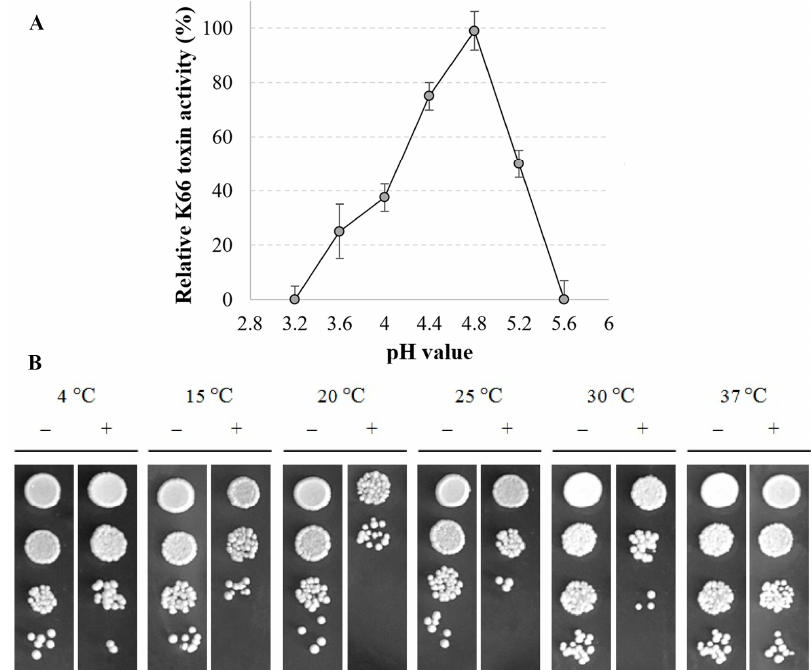
Figure 4. Impact of pH and temperature on K66 toxin functionality. ( A ) Sensitive S. cerevisiae strain a’1 was seeded into MBA medium (2 × 10 6 cells/plate, adjusted to pH values between 3.2 and 6) and 100 µL of the concentrated K66 toxin poured into 10 mm wide wells, cut in the agar layer. Plates were incubated for 2 days at 25 °C, non-growth zones around the wells measured and expressed as mean of three independent experiments in percent ± SD. ( B ) Sensitive yeast a’1 cells (5 × 10 5 cells) were mixed with 500 µL of 100-fold concentrated K66 toxin or the same volume of heat-inactivated K66 toxin and incubated for 24 h at different temperatures. Yeast cells were then serially diluted and spotted onto YPD-agar plates following for 2 days incubation at 25 ◦